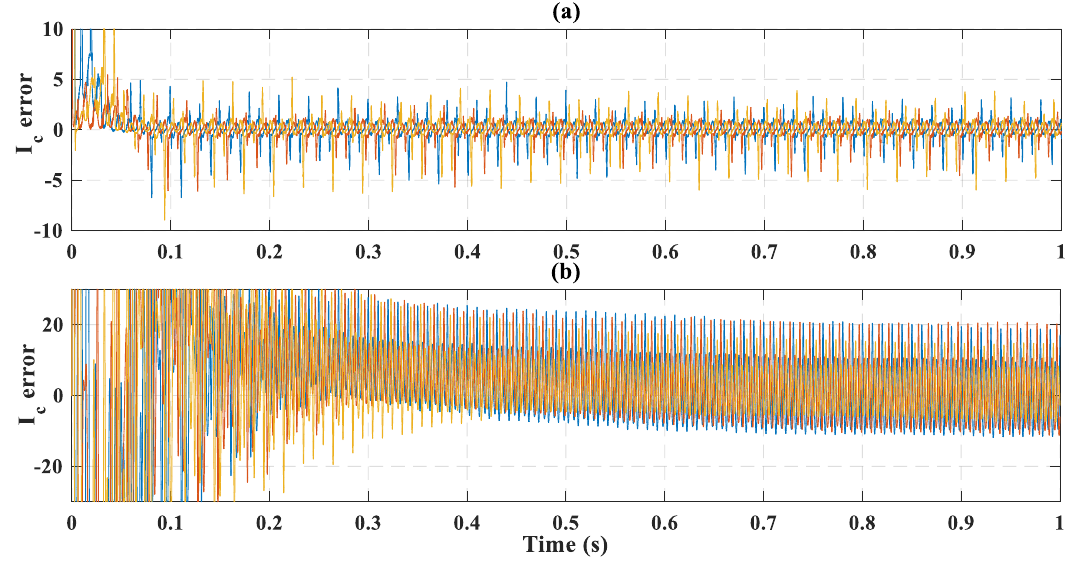
Figure 12 . Circulating current error; ( a ) SMC; ( b ) PR . Figure 12. Circulating current error; ( a ) SMC; ( b )